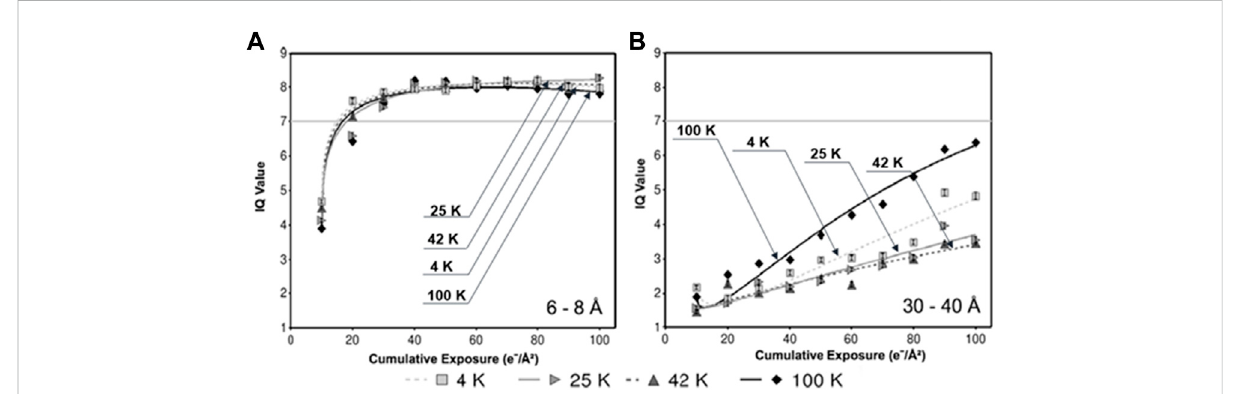
FIGURE 6 Radiation-induced decay of IQ values at different specimen temperatures. (A) IQ values within the resolution zone of 6 – 8 Å, (B) and zone of 30 – 40 Å, in which each data point represents the mean IQ value of all Bragg peaks within the speci fi ed resolution zone at the speci fi ed cumulative exposure at the speci fi ed temperature. Reproduced with permission (Bammes et al.,